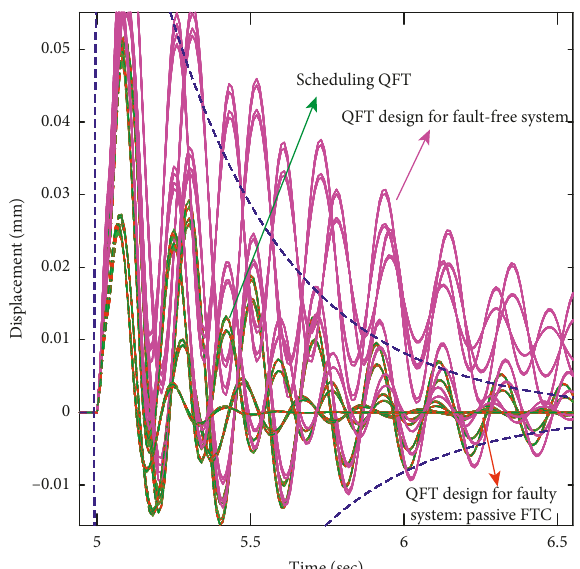
Figure 8: The zoomed-in view of Figure 7 between the time instant t 5sec and (cid:29)